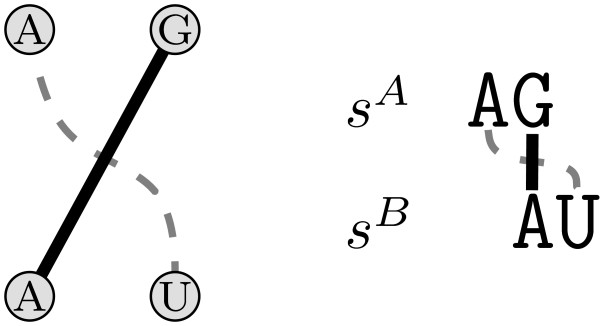
Crossing lines. Sequences sA = AG and sB = AU are given. The solid line between G and A represent the alignment of these two nucleotides. If we added the gray dashed line, this would induce an ordering conflict.